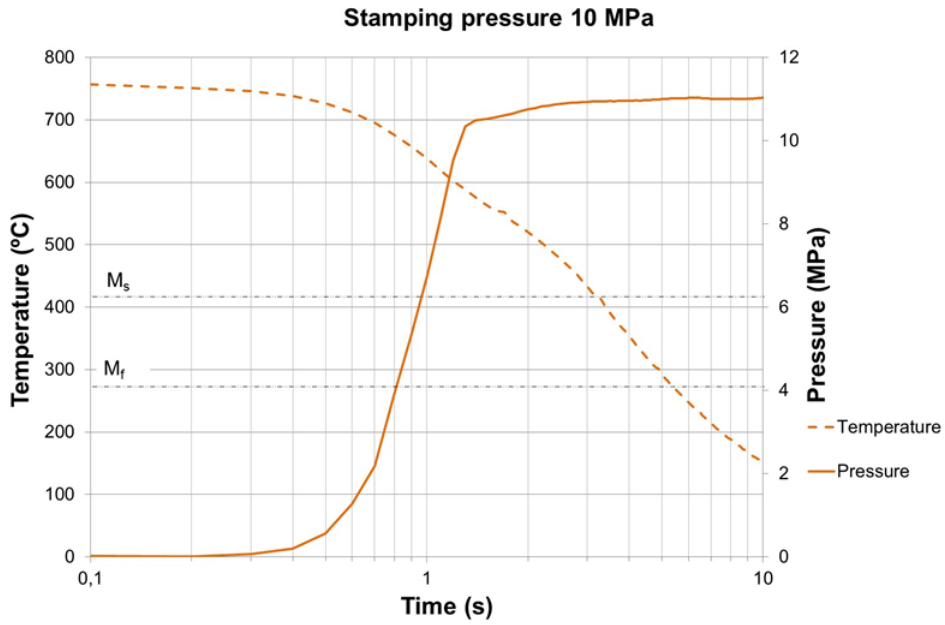
Figure 11. Temperature–pressure–time plot for a pressure set-point of 10 MPa.